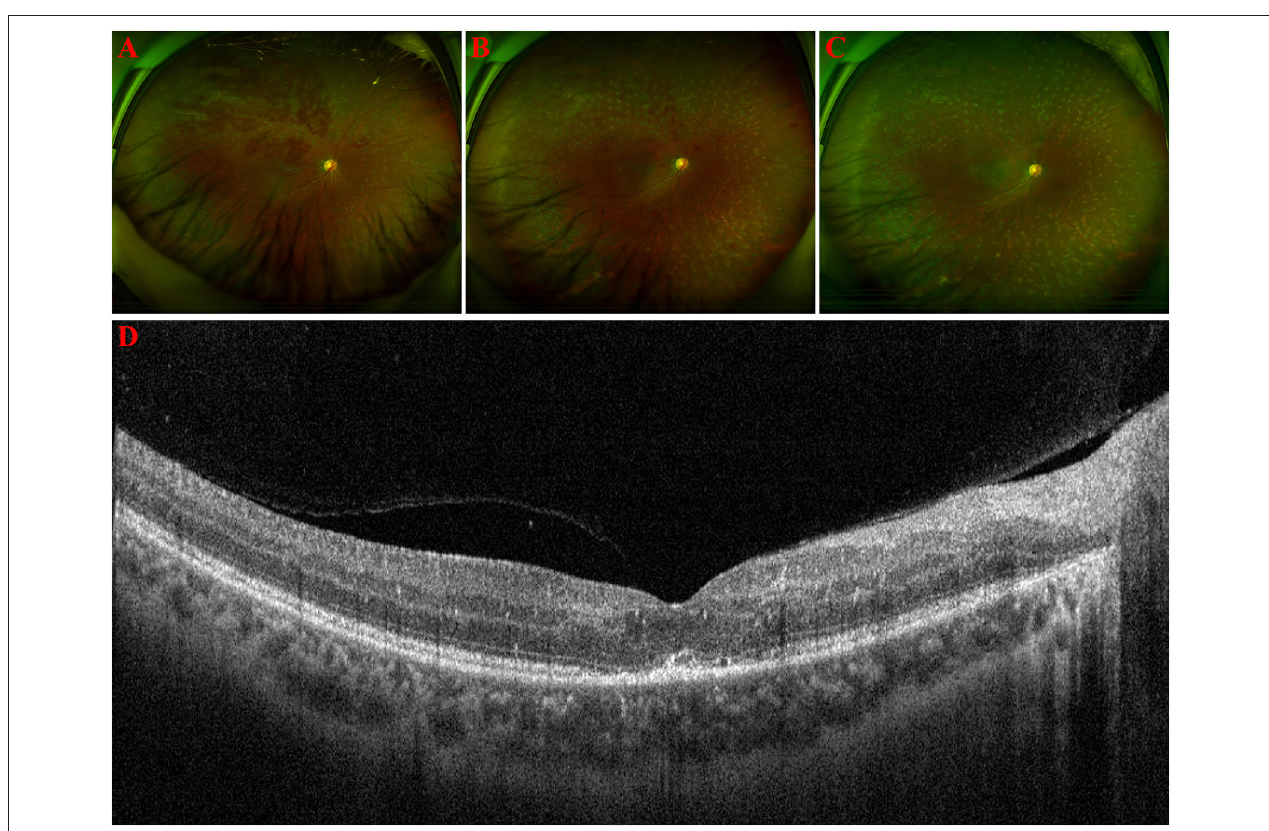
FIGURE 2 | (A–C) Ultra-wide-angle fundus photographs of the right eye from 1, 2, and 5 months post-treatment. White sheathing of the vessels alleviated first, and supratemporal hemorrhage resolved at 5 months later. (D) Optical coherence tomography of the right eye 1 month after treatment showing disappearance of subretinal exudation and much less vitreous